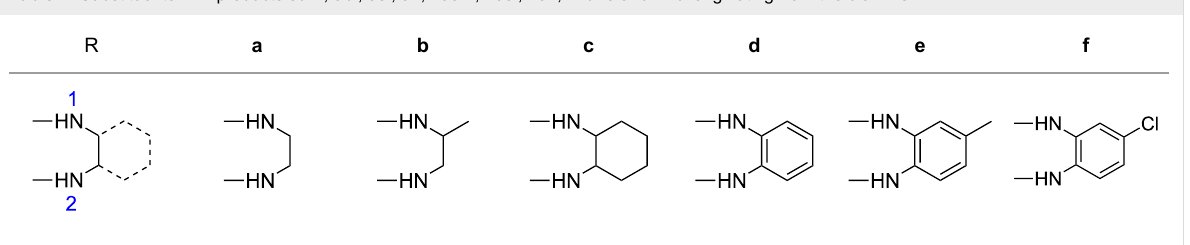
Table 4: Substituents R in products 9a–f , 9b' , 9e' , 9f' , 10c–f , 10e' , 10f' , 11a–e and 11b' originating from the